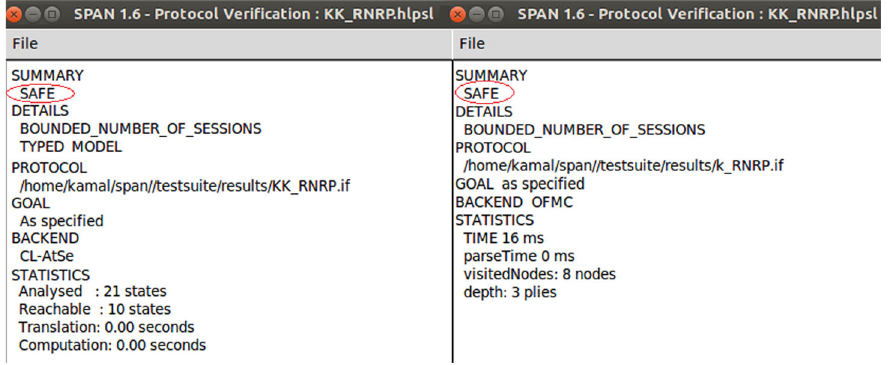
Fig. 11 Results of ATSE and OFMCE for RNRP